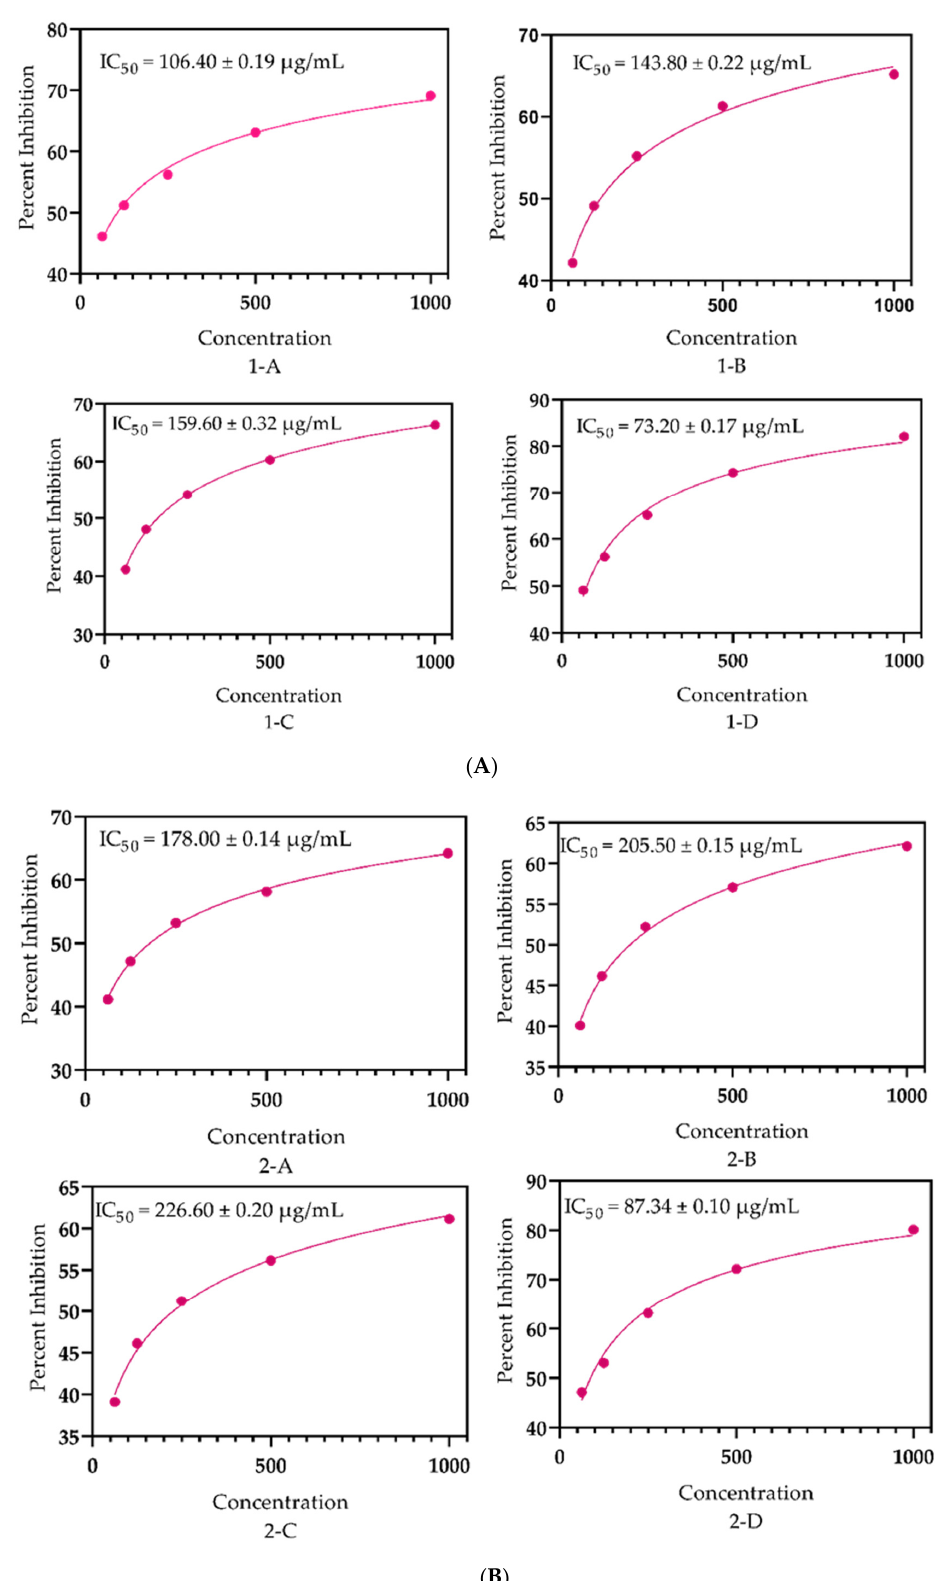
Figure 4. ( A ) Antioxidant potential of the essential oils of O. arabicus ( 1 - A ) flowers, ( 1 - B ) leaves ( 1 - C ), stems, and ( 1 - D ) ascorbic acid via the DPPH assay. ( B ) Antioxidant potential of the essential oils of O. arabicus ( 2 - A ) flowers, ( 2 - B ) leaves, ( 2 - C ) stems, and ( 2 - D ) ascorbic acid via the ABTS assay.